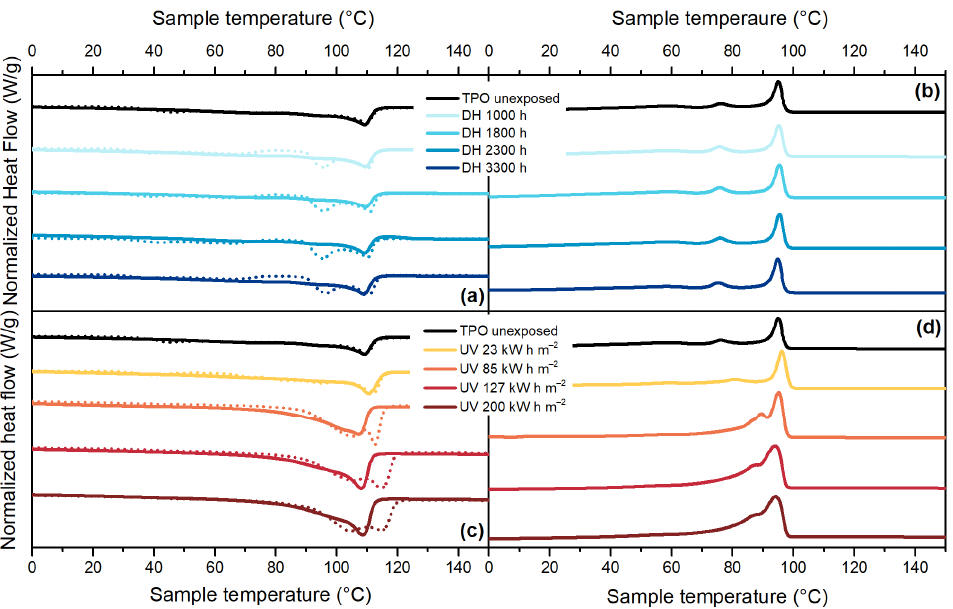
Figure 9. DSC thermograms for TPO. First heating curves (dashed lines) and second heating curves (full lines) from samples exposed to DH test ( a ). Cooling curves for samples exposed to DH test ( b ). First heating curves (dashed lines) and second heating curves (full lines) from samples exposed to UV test ( c ). Cooling curves for samples exposed to UV test ( d ).